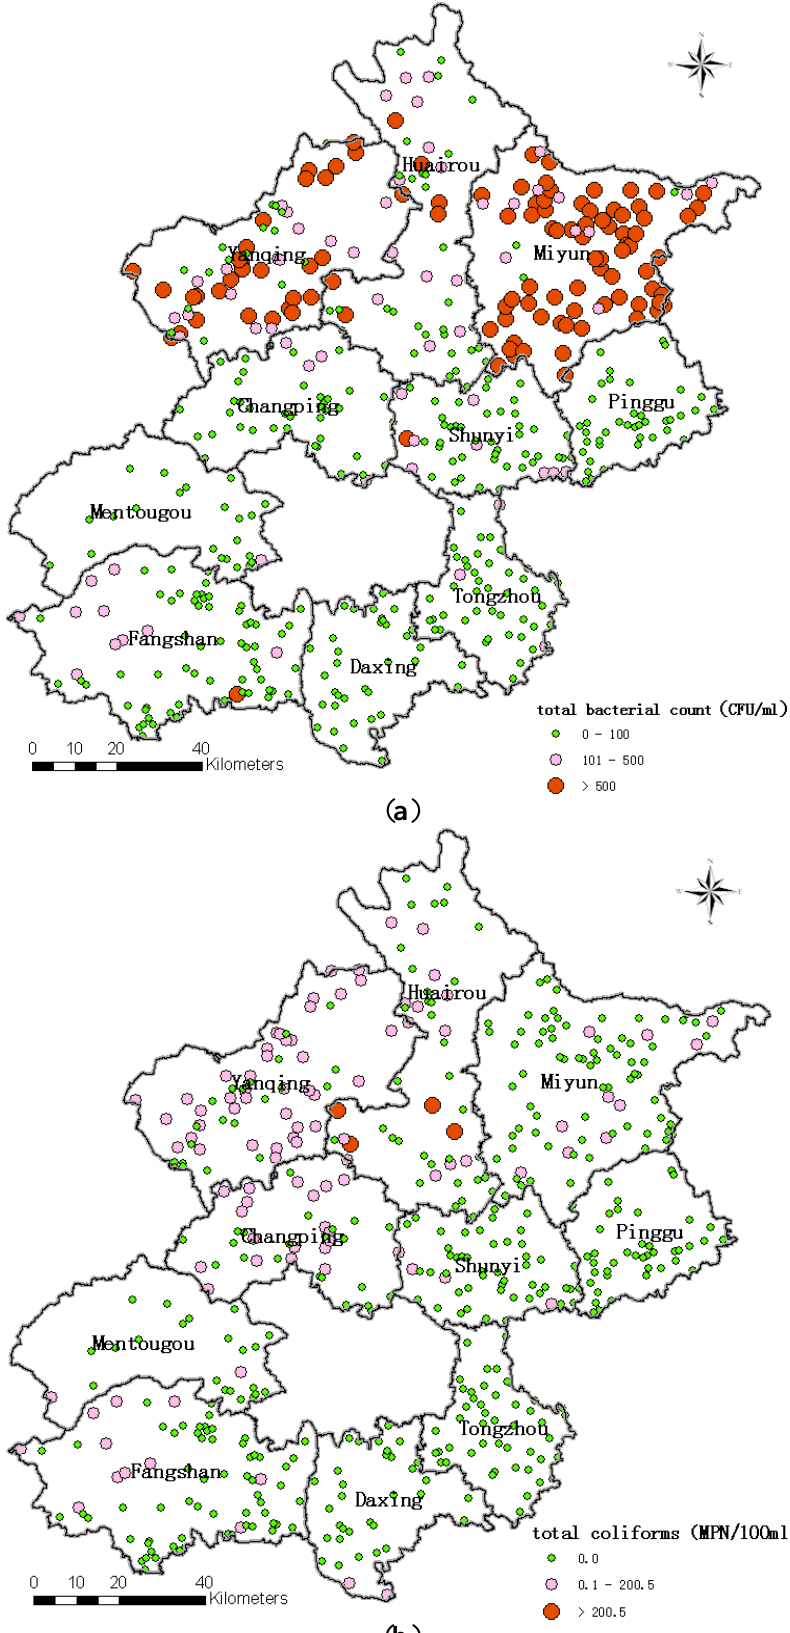
Figure 2. Bacterial contamination in finished water in rural areas around Beijing in summer by districts. ( a ) total bacterial count; ( b ) total coliforms; ( c ) Escherichia coli ; N =